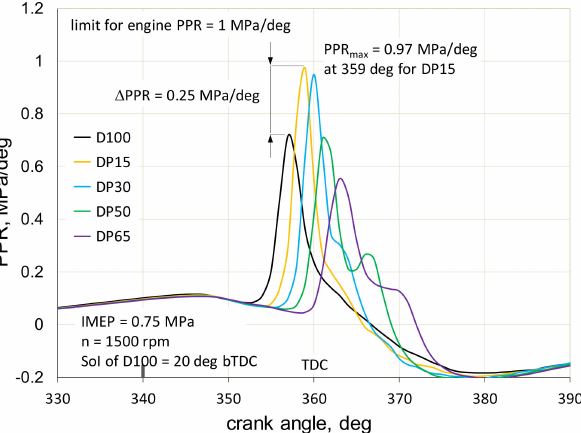
Figure 4. Peak pressure rise (PPR) characteristics for dual-fuel engine fueled by diesel and propanol with an alcohol content from 0 to